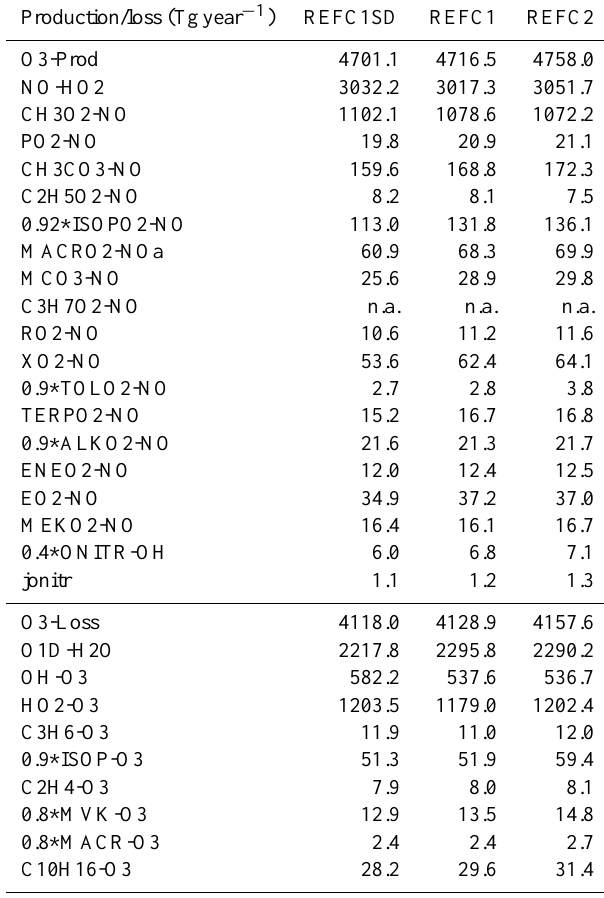
Table A3. Tropospheric ozone production and loss rates calculated for explicit reaction rates, O3-Prod and O3-Loss are the sum of the specific reaction